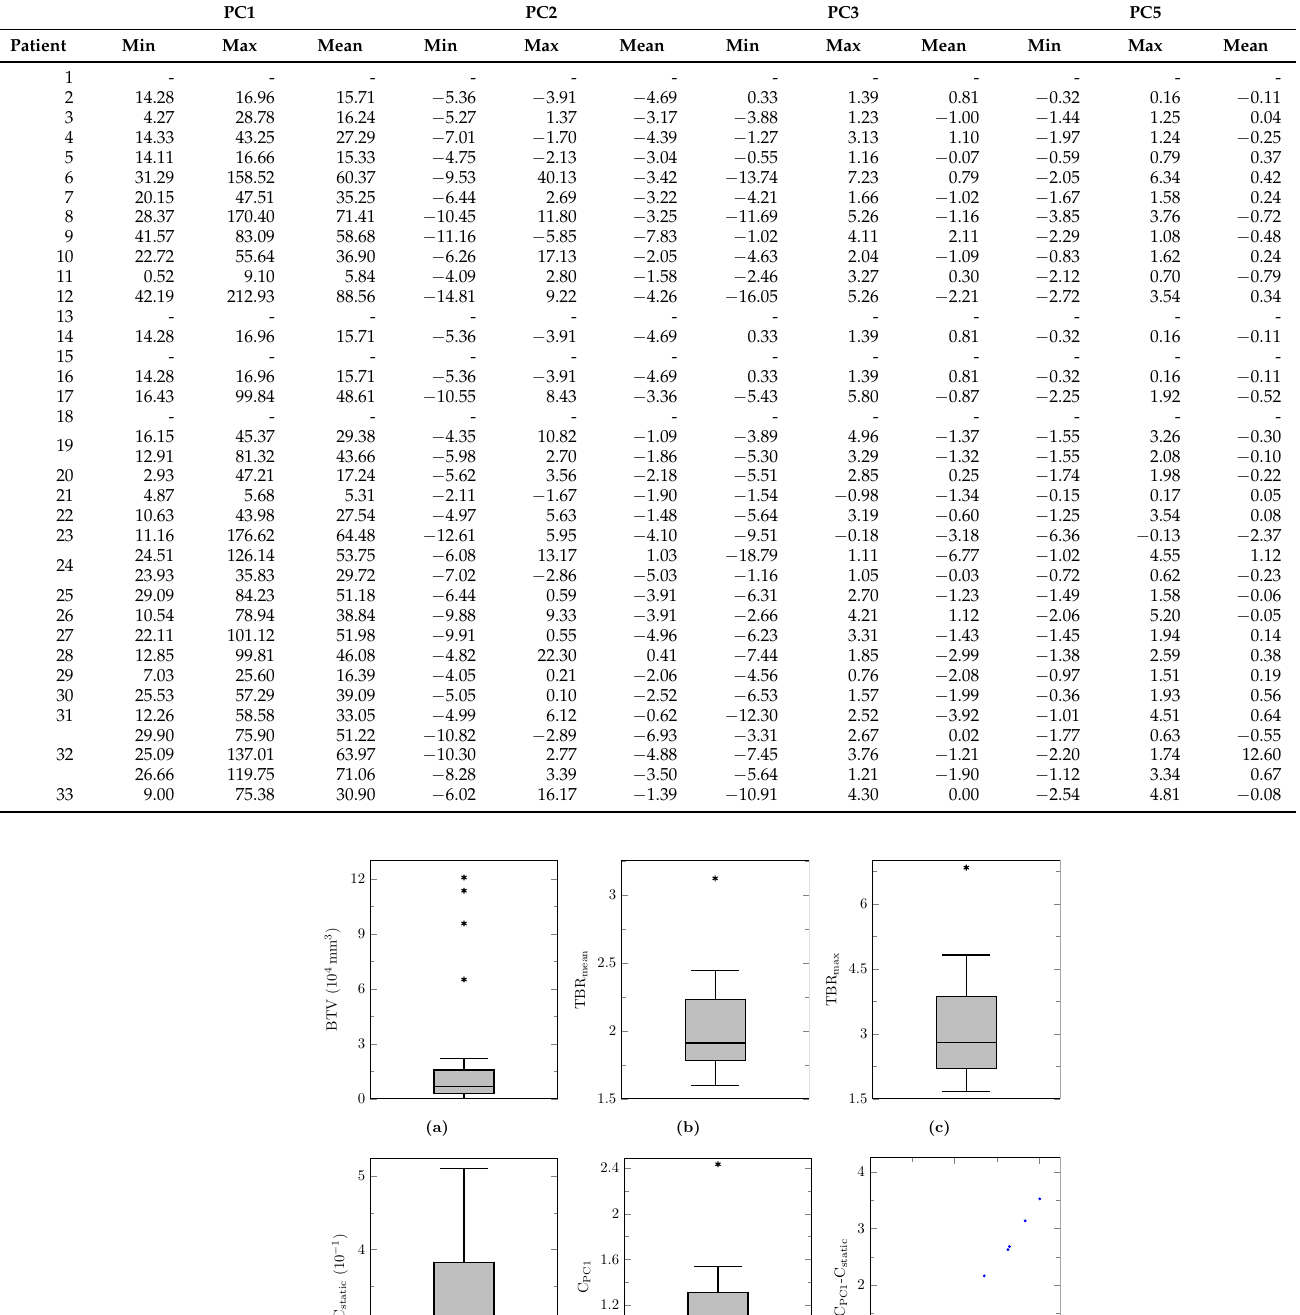
Table A5. Minimum, maximum, and mean PC values computed for each lesion within the BTV.